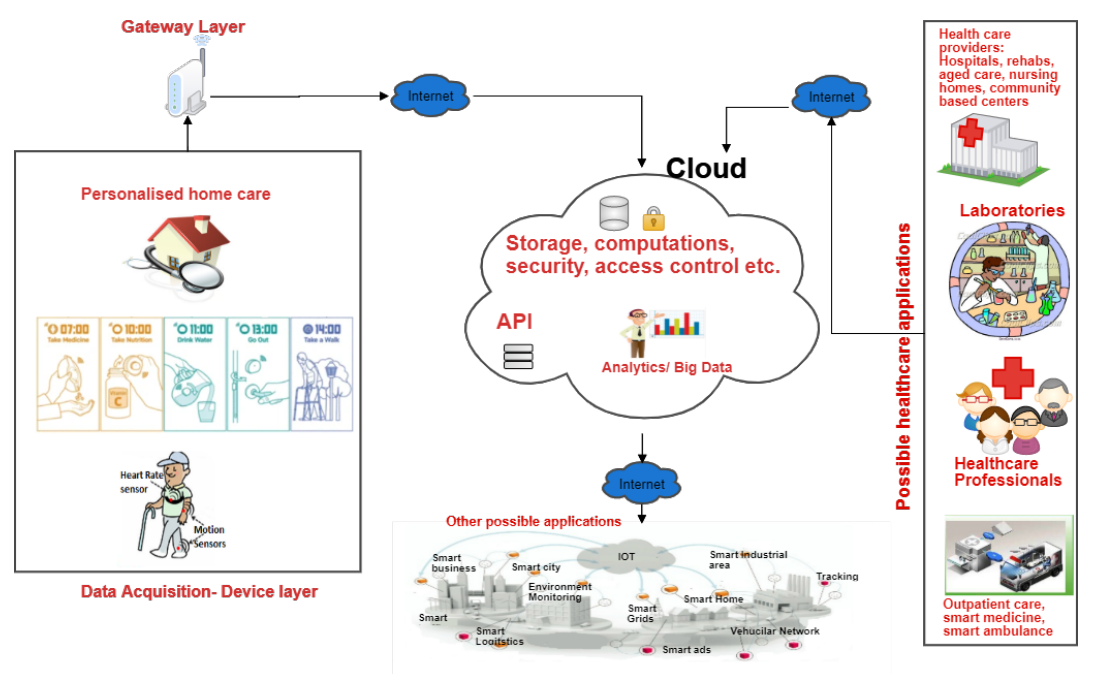
Figure 2. Architecture of CloudIoT Personalised Healthcare (PH)